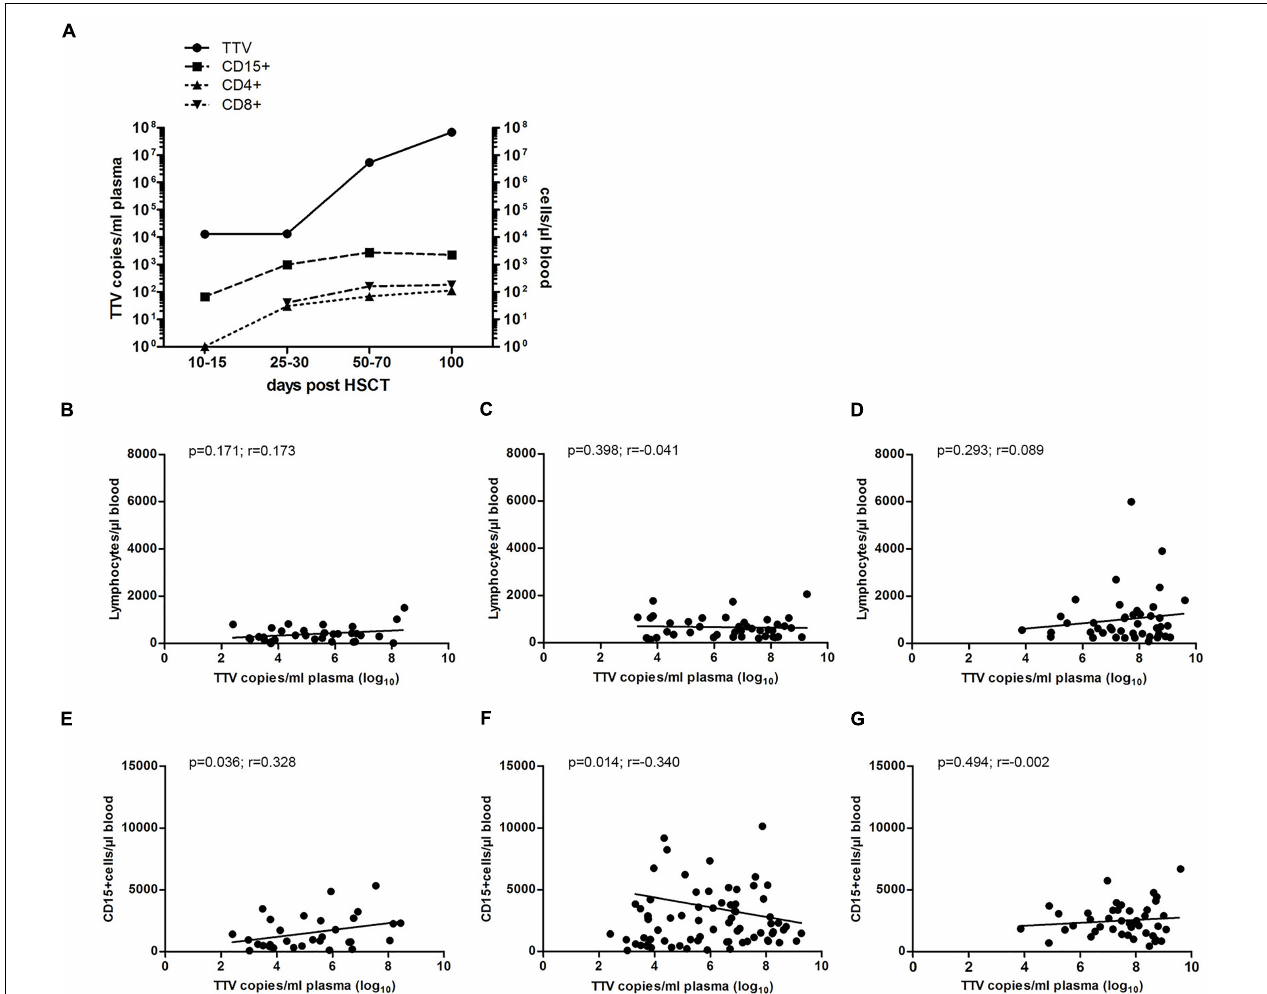
FIGURE 2 | Correlation of TTV plasma levels with granulocyte and lymphocyte numbers. Median TTV DNA copy numbers per ml plasma were analyzed by RQ-PCR. (A) The kinetics of TTV load (solid line) representative of all 43 patients investigated are shown in relation to the median cell numbers of granulocytes, CD4 + and CD8 + cells (dashed lines) at the indicated time windows post-HSCT. Spearman correlation of TTV levels and total lymphocyte counts at days (B) +30, (C) +60, and (D) +100 post-HSCT and (E–G) granulocyte counts (CD15 + cells) at days +30, +60, and +100 post-HSCT, respectively, is shown for the entire cohort of 43 patients. The p -values and correlation coefficients (r) are